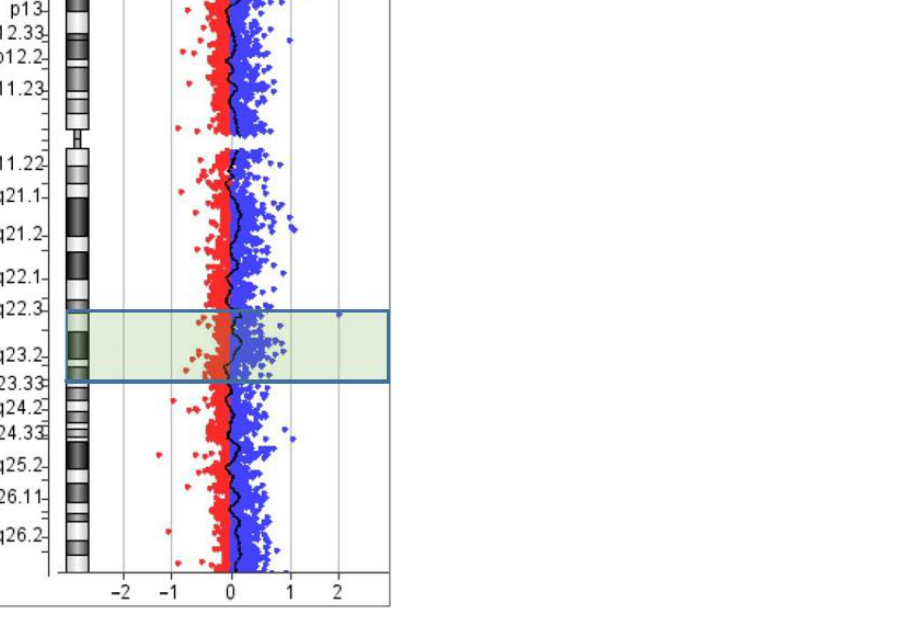
Figure 9. The aCGH profile of chromosome 10. The position of inverted region 10q22.2–q23.3 is highlighted.